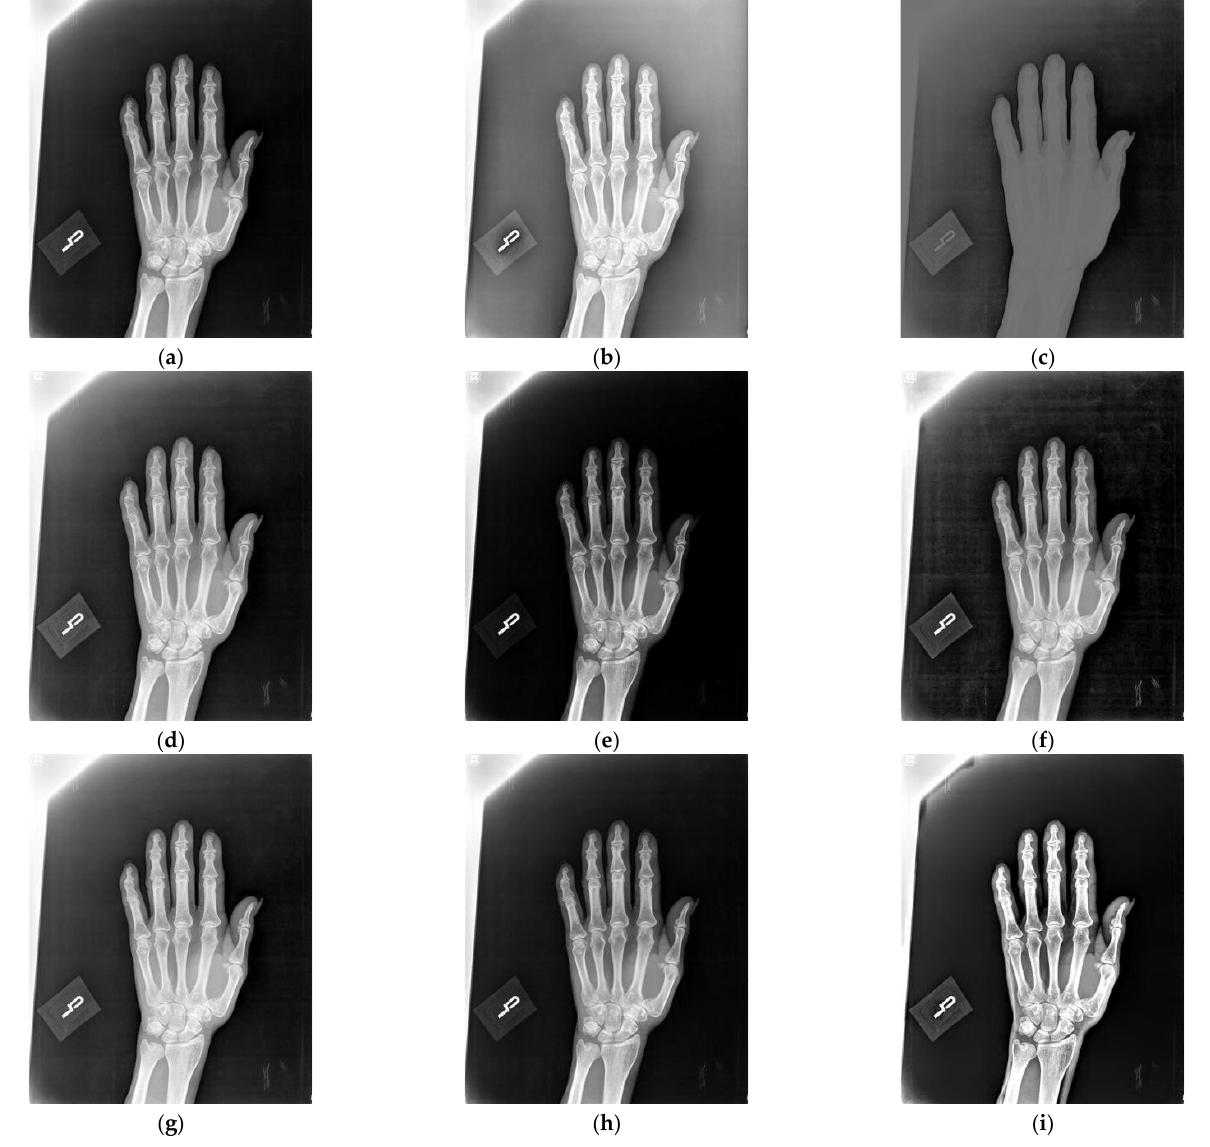
Figure 2. Comparison on X-ray image 2. ( a ) Original image; ( b ) McCann; ( c ) RLBHE; ( d ) RESIHE;